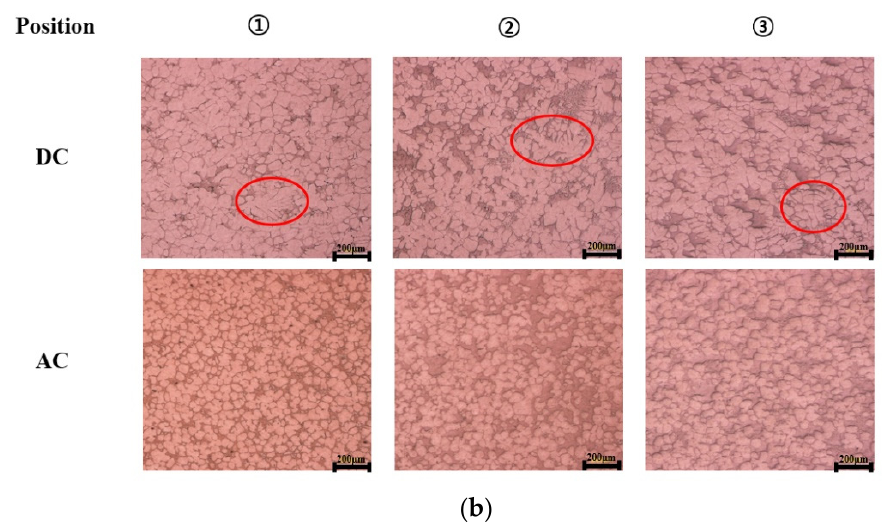
Figure 8. Optical micrographs showing the microstructure of A356 according to the current input method: ( a ) 20% 𝑓𝑠 , ( b ) 30% 𝑓𝑠 .